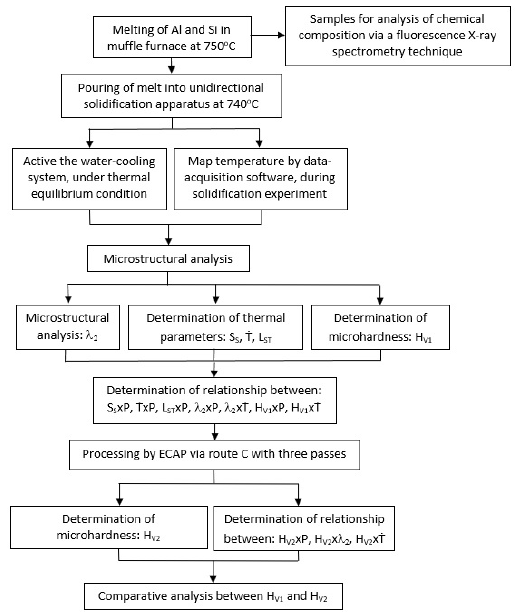
Figure 1. Flowchart of the